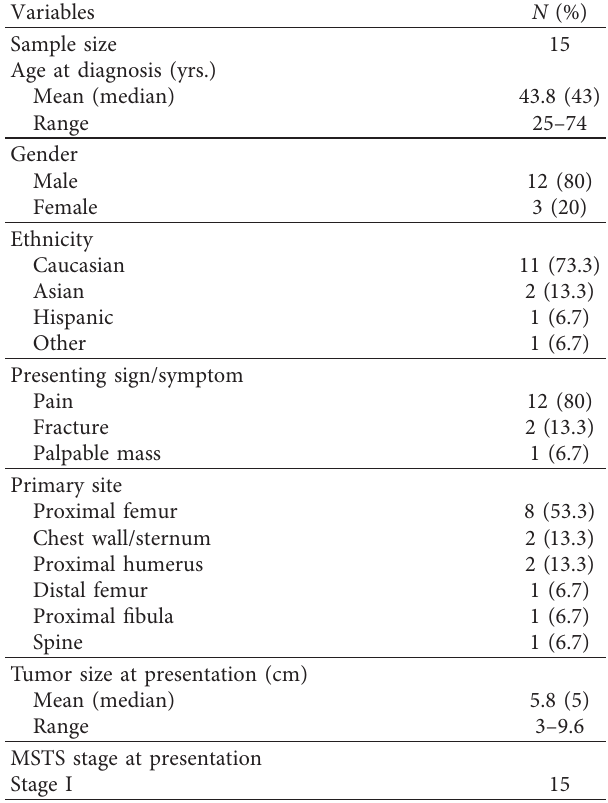
Table 1: Clinical characteristics.